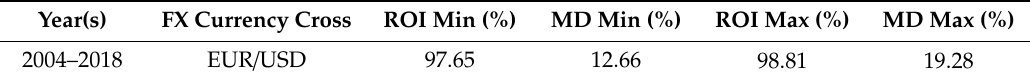
Table 3. Trading performance analysis of the proposed pipeline: dynamic ROI / MD.